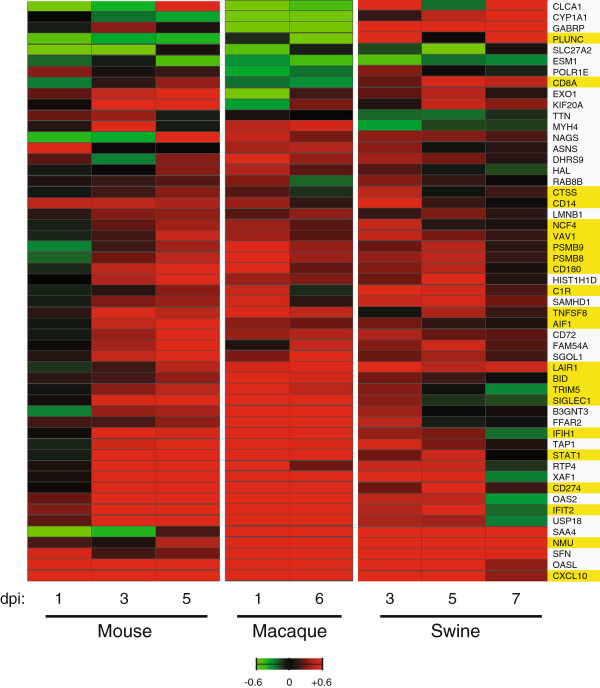
Heatmap of 53 genes commonly differentially regulated across all three species infected with CA04 virus. Average log10(ratio) expression of 53 DE genes induced by CA04 virus. In mice and swine, infected lung gene expression is referenced to specie-matched mock at each time point. In macaques, infected lung gene expression is relative to an uninfected lung reference pool at each time point. Red indicates expression was increased relative to the control reference and green indicates that expression was decreased relative to the control reference. Saturation is 4-fold. A total of 22 DE genes associated with inflammatory response are highlighted on the right; yellow denotes positive association.